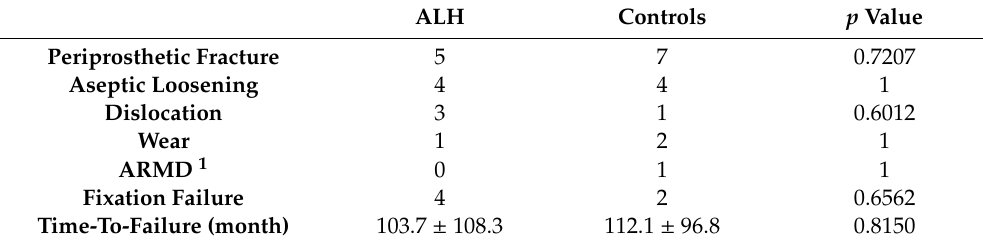
Table 2. Diagnosis and